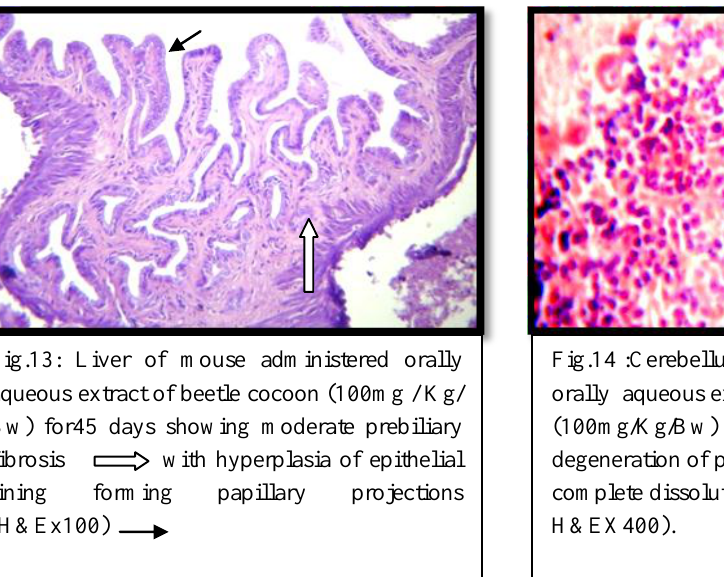
Fig.14 :Cerebellum of mouse administered orally aqueous extract of beetle cocoon (100mg/Kg/Bw) for 45 days showing degeneration of pukinji cells with complete dissolution of the others (